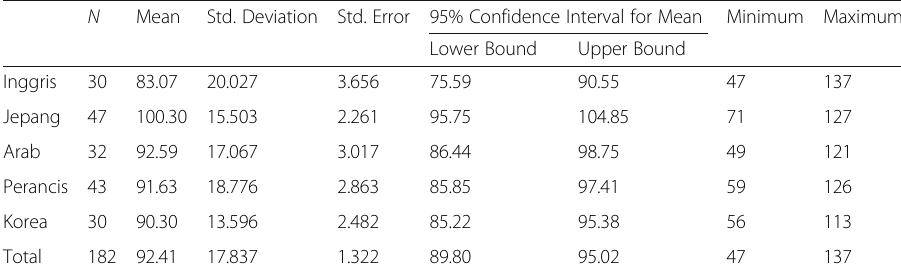
Table 1 Descriptive Data of Foreign Language Anxiety Scale N Mean Std. Deviation Std. Error 95% Confidence Interval for Mean Minimum Maximum